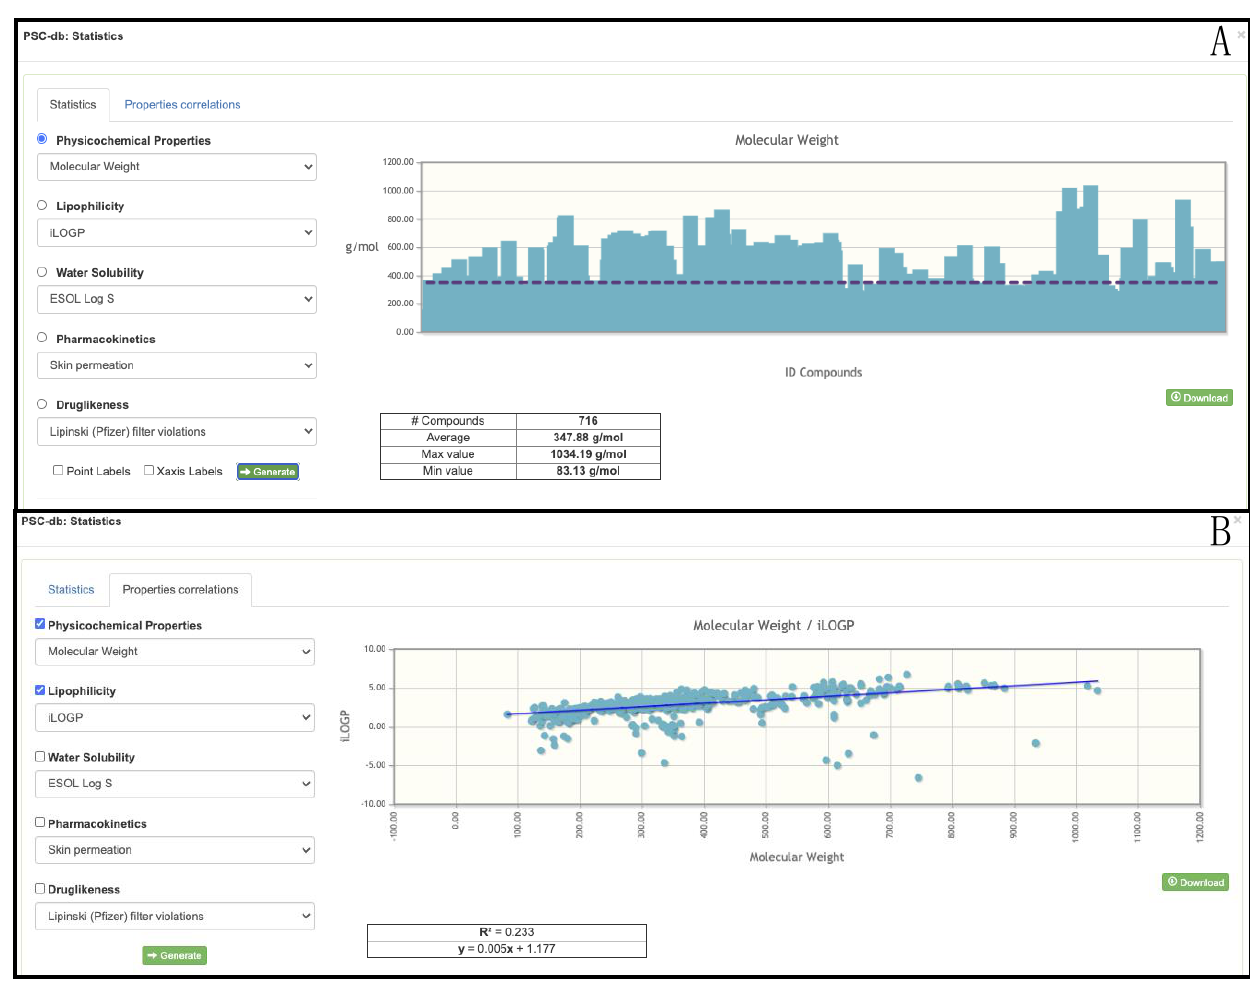
Figure 3. PSC statistics based on the calculated physicochemical and pharmaceutical properties. Statistics for the molecular weight ( A ) and the correlation between the molecular weight and the lipophilicity ( B ) of 716 selected alkaloids are shown.